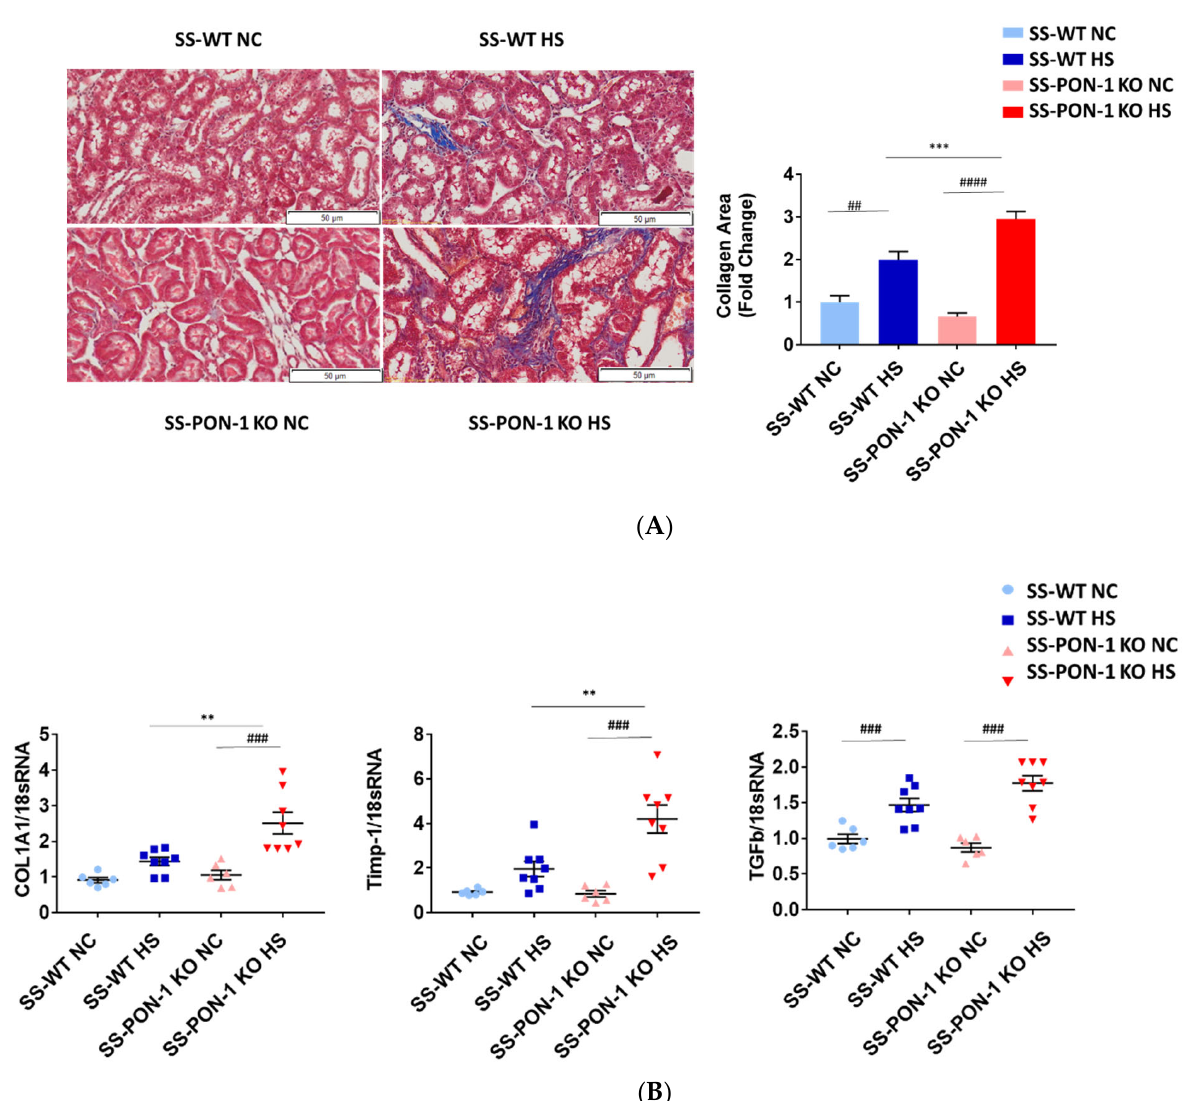
Figure 3. Targeted mutation of paraoxonases-1 contributes to increase fibrosis in renal tissue as measured by ( A ) collagen area (Pixels) (N = 6) and ( B ) key fibrotic gene expression in renal tissue. Quantitative PCR from Dahl SS-PON-1 KO and SS rats after 5 weeks high-salt diet (8% NaCl) or normal chow (HS N = 8, NC N = 6). SS-PON-1 KO rats show a significant increase in renal fibrosis, compared to SS rats following 5 weeks 8% high-salt diet, ** p < 0.01, *** p < 0.001 vs. high-salt, ## p < 0.01, ### p < 0.001, #### p < 0.0001 vs. normal chow.